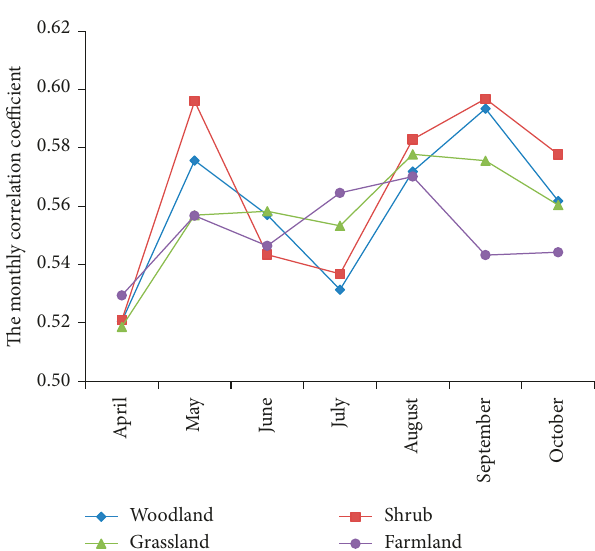
Figure 12: The monthly correlation coefficient between SMAI and VCI in different vegetation